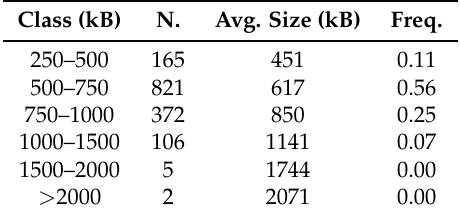
Table 2. Descriptive statistics of heterozygosity-rich regions (ROHet) by size